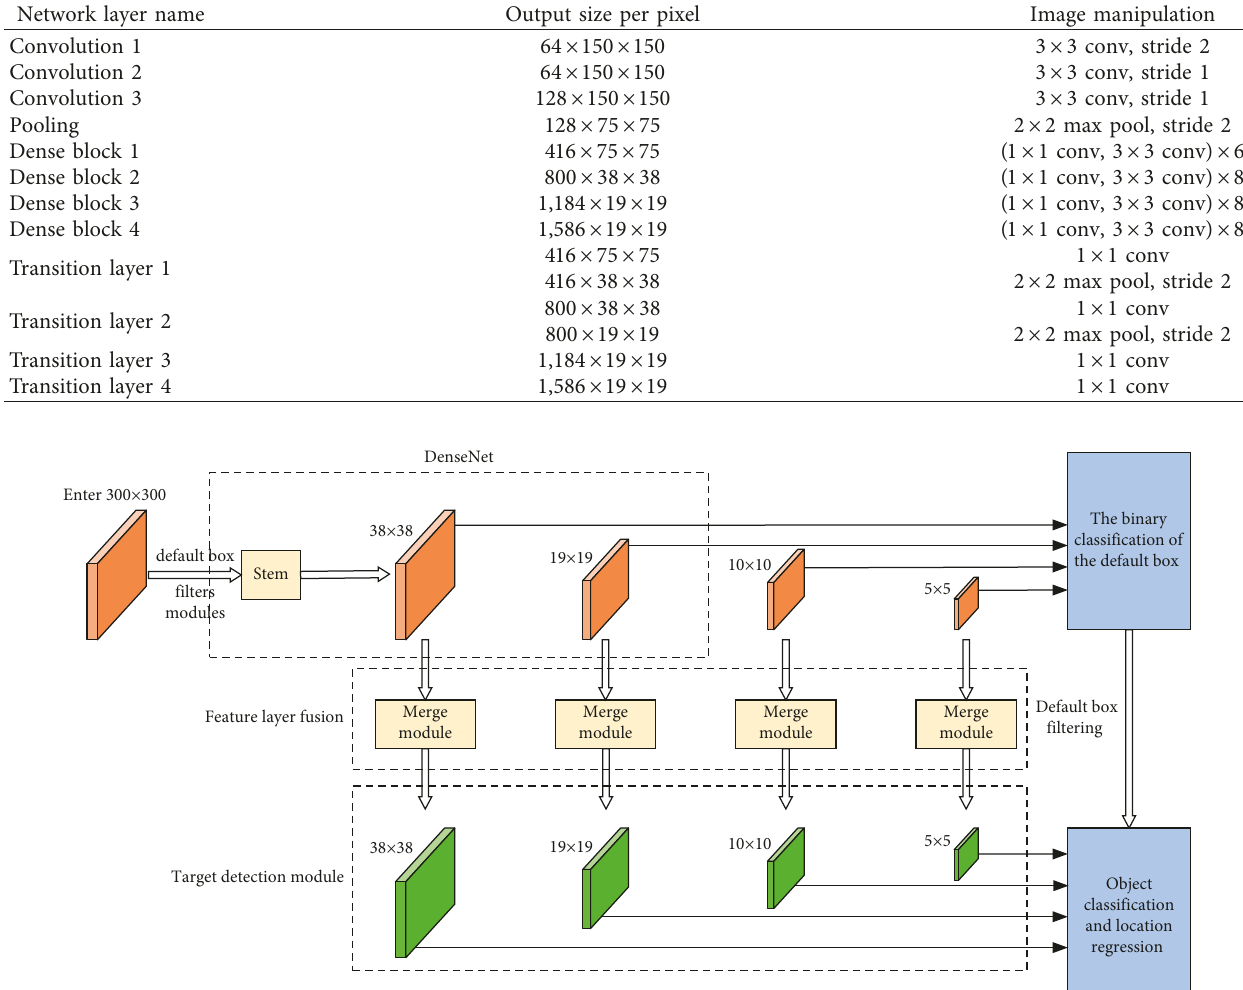
Figure 2: Network structure of the proposed algorithm.